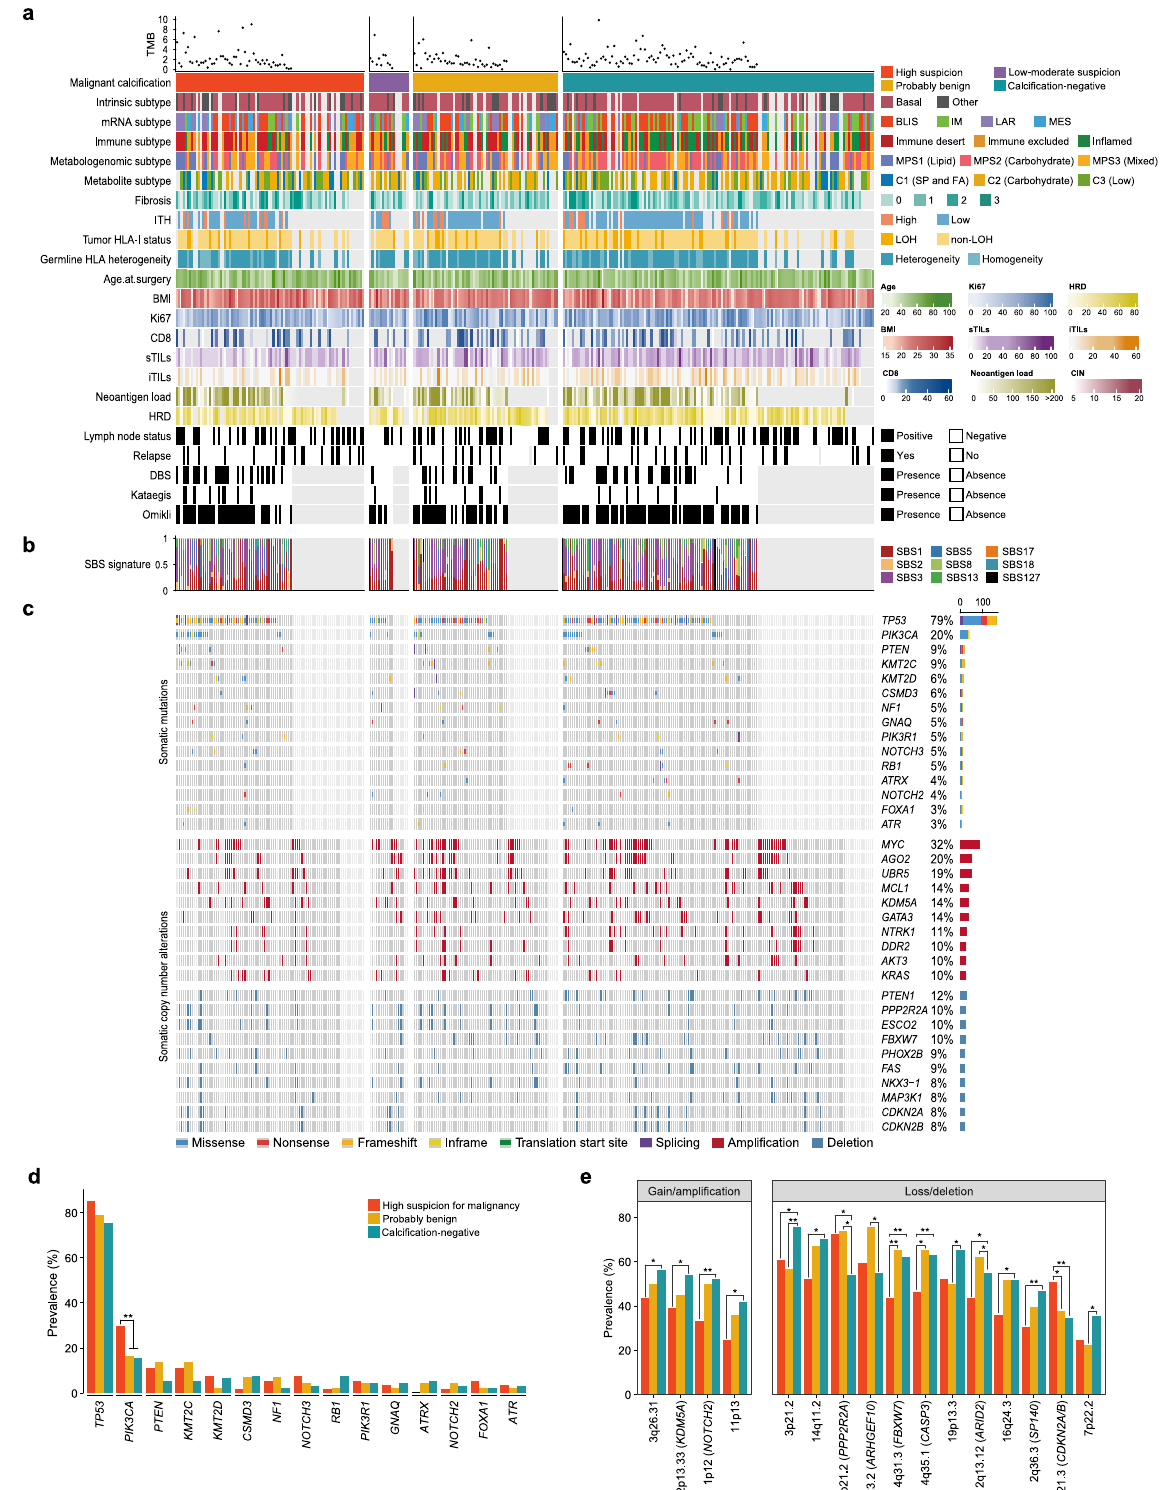
Fig. 2 Molecular landscape of the FUSCCTNBC-mammography cohort. a Three hundred and twelve TNBC samples annotated with clinical and molecular features. Samples are ordered by calci fi cation status. b Somatic mutations of the top mutated genes. Genes are ordered by the total mutation frequencies. c Copy number alteration of cancer-related genes. Only ampli fi cations (GISTIC + 2) and deep deletions (GISTIC -2) are presented. d Gene-level mutation frequencies across different calci fi cation groups. “ ** ” denotes a P -value of < 0.01. e Region-level SCNA frequency across different calci fi cation groups. “ ** ” denotes a P -value of < 0.01 and “ * ” denotes a P -values of < 0.05. Logistics regression models using the binomial family were performed to obtain P values for the comparison analyses of mutations and SCNAs between different calci fi cation